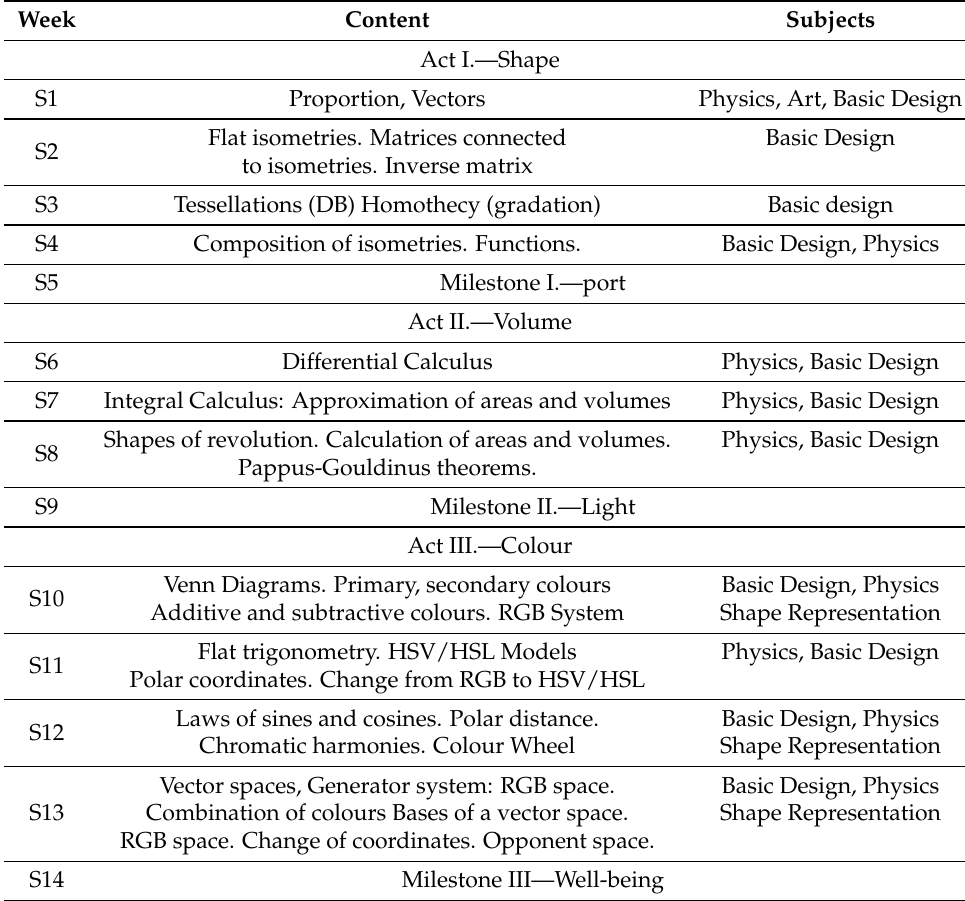
Table 4. Sessions, timing and subjects